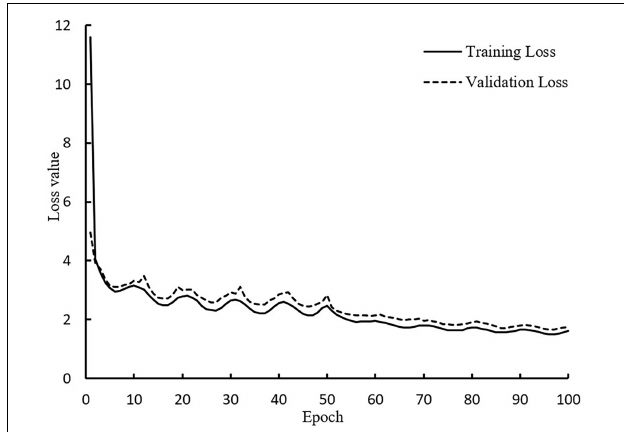
FIGURE 5 | Loss curve during training process.